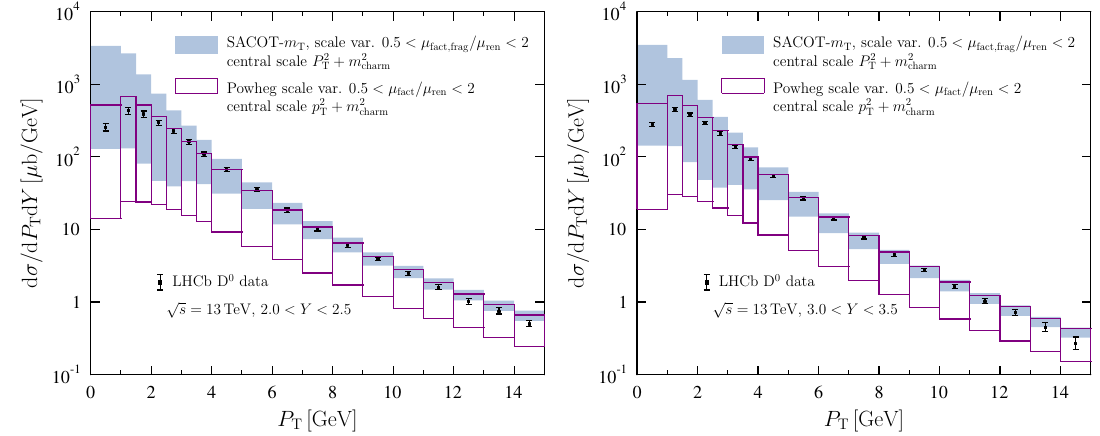
Figure 11 . A comparison of scale uncertainties between GM-VFNS (light-blue band) and Powheg p (purple boxes) calculations for D 0 + D 0 production at s = 13 TeV for rapidity bins Y 2 [2 : 0 ; 2 : 5] (left) and Y 2 [3 : 0 ; 3 : 5] (right). Also the data from LHCb [2] are shown as in (cid:12)gure 7.